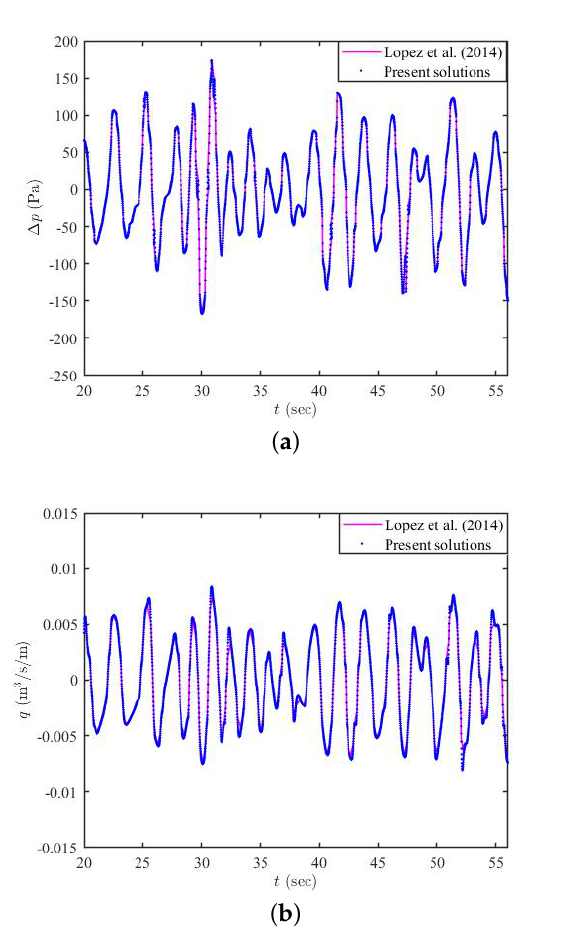
Figure 3. Comparison of present numerical results ( a ) pressure drop, and ( b ) flow rate vs. the flow-time, with the results of [22] in the case of regular